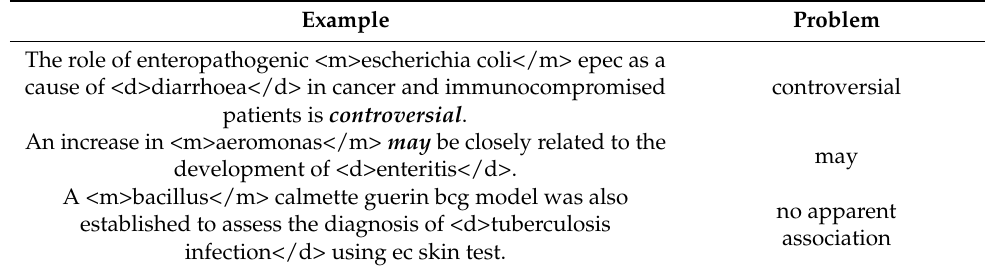
Table 2. Some examples of problematic